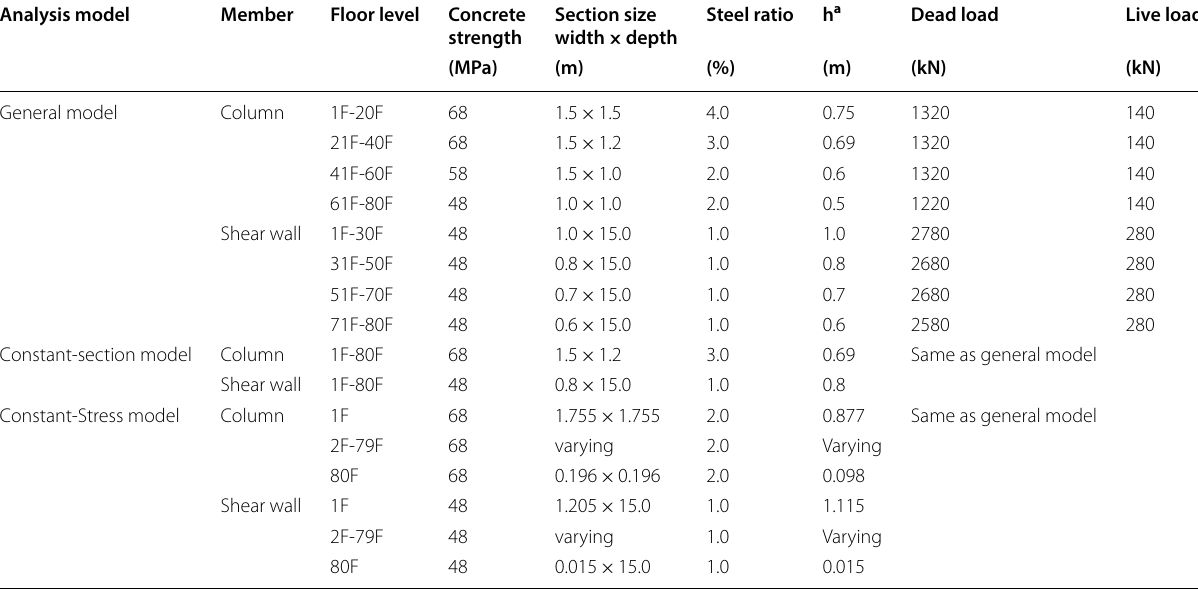
Table 1 Properties of elements and loads used in 80-story analysis models.